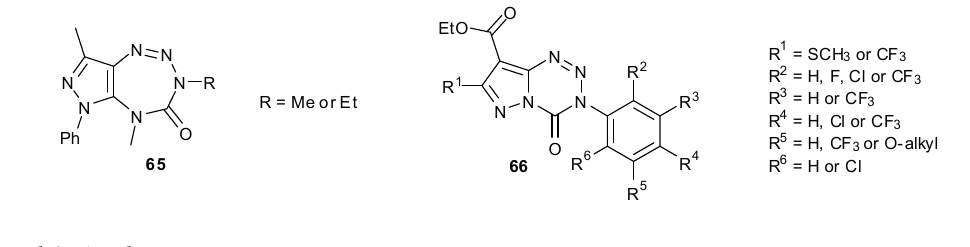
Figure 13. Unstable tetrazepines [74], and pyrazolotetrazinone herbicidal agents